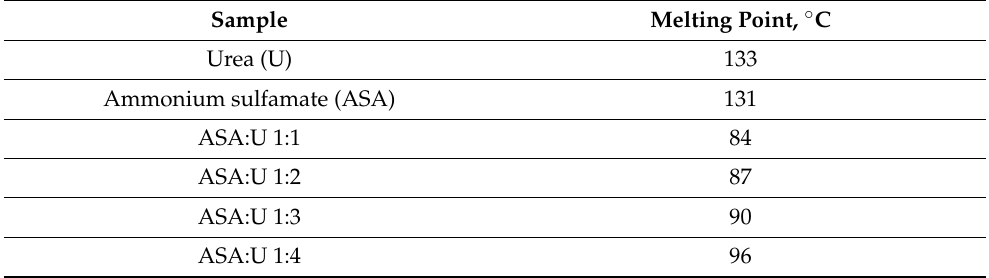
Table 2. Experimental and theoretical melting points of the ammonium sulfamate–urea system.